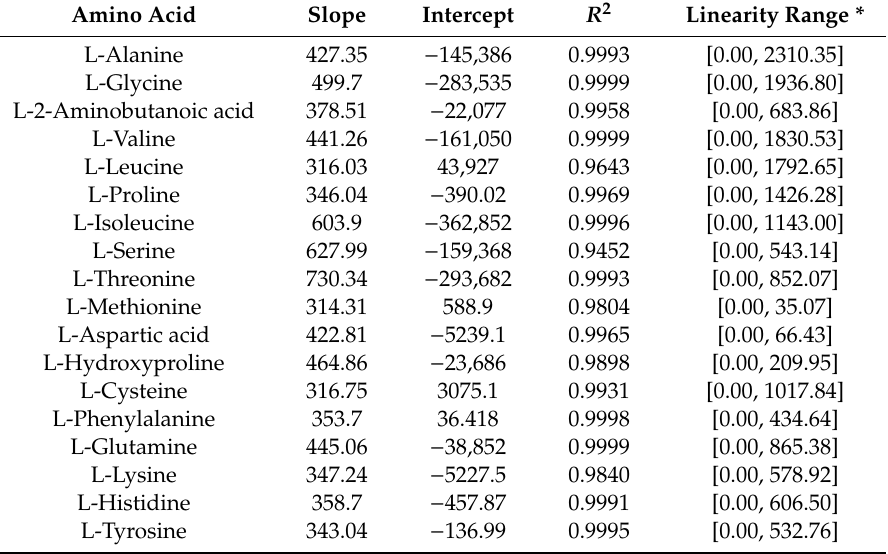
Table 3. Calibration parameters for quantitative determination of amino acids. Amino